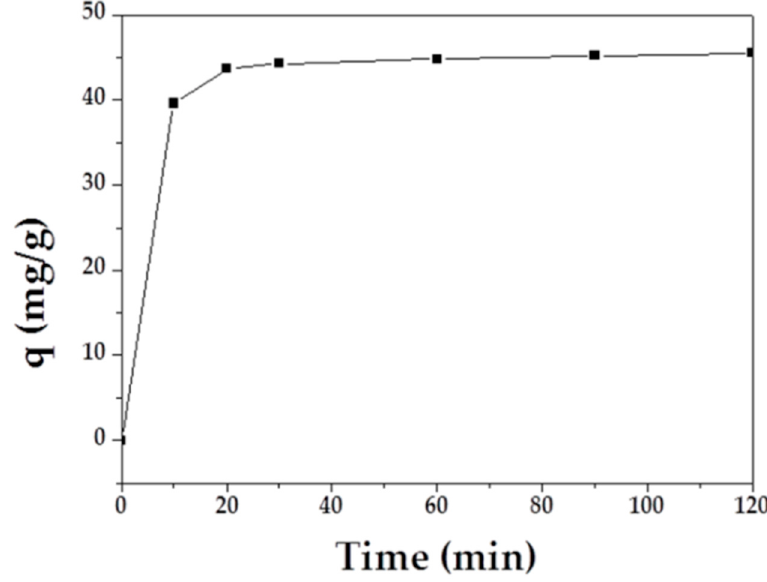
Figure 5. E ff ect of contact time on the adsorption of MAFC to emulsified oil. Figure 5. Effect of contact time on the adsorption of MAFC to emulsified oil. Figure 5. Effect of contact time on the adsorption of MAFC to emulsified oil.